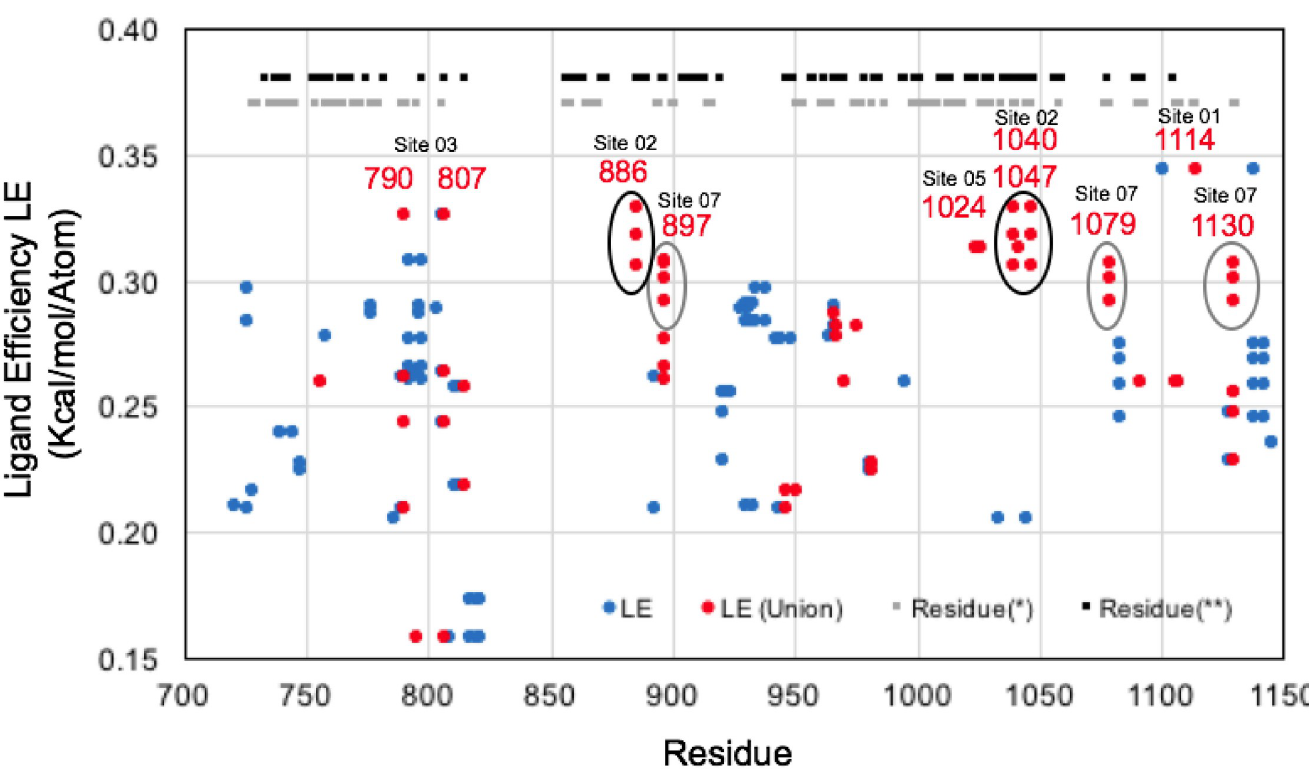
Fig 17. Ligand efficiencies from pharmacophore mapping of the S2 spike protein as a function of residue. All residues identified as having a high druggability and sequence-conservation by [120] are shown as small gray or black squares at the top of the figure. Black indicates a higher sequence conservation compared to gray between more distantly related coronaviruses (SARS, MERs, etc). Ligand efficiencies of the TOP50 sites (according to residues provided S1 Table in S1 File) are shown as either blue or red dots as a function of residue. Blue dots are pharmacophore sites (and corresponding residues) not identified in the analysis of Trigueiro-Louro et al., [120] whereas red dots indicate binding site residues identified as a Union of both datasets. The residues that define pharmacophore Sites 01, 02, 03, 05, and 07 exhibit high relative ligand efficiency to other sites on the S2 Spike protein and were also identified by Trigueiro-Louro et al., [120].